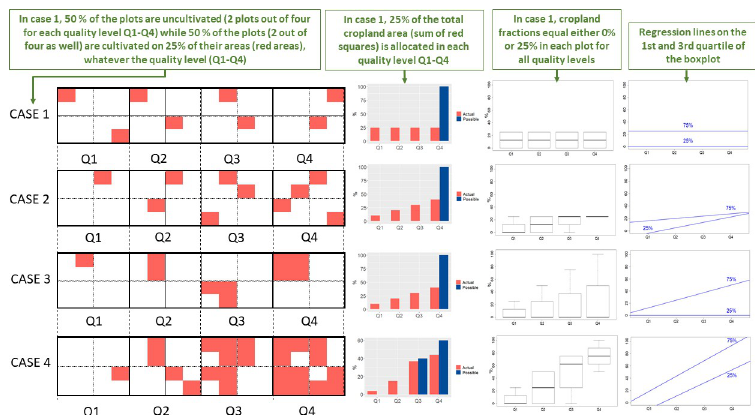
Fig 1. Illustrative patterns of cropland allocation over a land quality gradient indicated by four land classes Q1, Q2, Q3, Q4 (Q1 = lowest quality, Q4 = highest quality) defined from the 1 st quartile, median, and 3 rd quartile of the considered quality index (suitability or accessibility). Four hypothetical regions are distinguished, with low (case 1) to high (case 4) cultivated areas. Each region includes 16 parcels (white squares). A fraction ranging from 0 to 100% of each parcel can be cultivated (red squares in the graphics on the left). The histograms (center left) describe the corresponding cropland distributions expressed in % of agricultural land allocated to each land class (in red) in comparison to theoretically optimal land allocations (in blue). The boxplots (center right) describe the distributions of the cultivated fractions within land classes. The line charts (right) show the regression lines on the 25% least cultivated areas and the 75% most cultivated areas. Case 1 corresponds to a random and homogeneous distribution of the cultivated areas over the parcels. Case 4 illustrates a strong preference for an allocation of cultivated land in high quality parcels. Cases 2 and 3 are